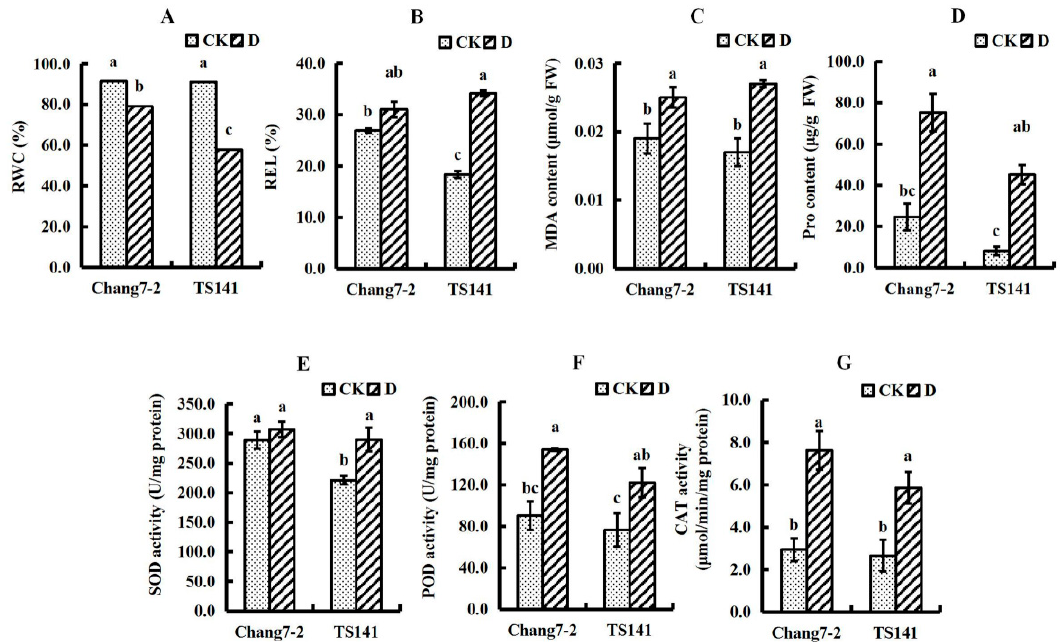
Figure 2. Physiological characteristics of Chang 7-2 and TS141 seedling roots under control and stressed conditions. Data are presented as the mean ± standard deviation. Lowercase letters indicate a significant difference at the 1% level. ( A ) RWC. ( B ) REL. ( C ) MDA content. ( D ) Pro content. ( E ) SOD activity. ( F ) POD activity. ( G ) CAT activity.